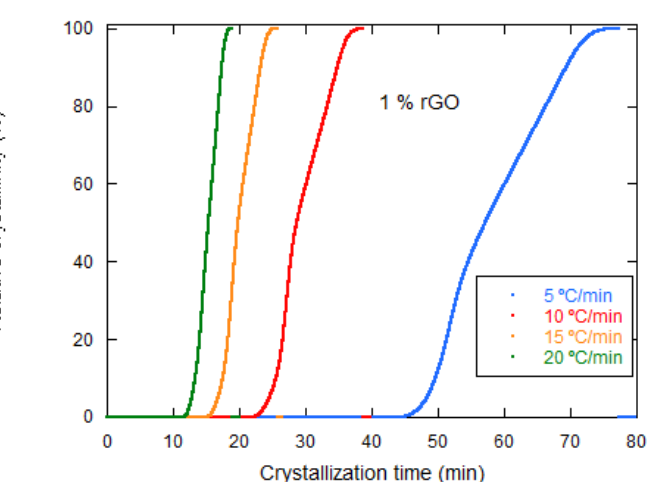
Figure 7. Relative crystallinity versus crystallization time for PLCL/rGO 1 wt% at different cooling